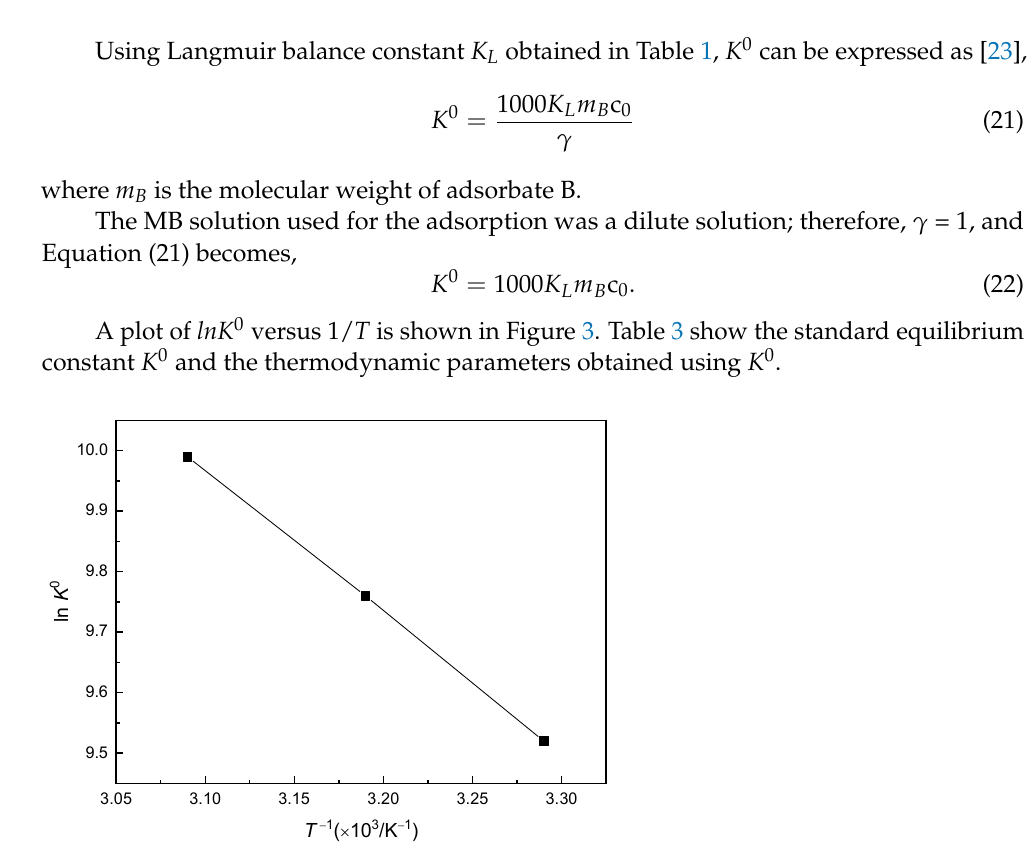
Figure 3. The relationship between lnK 0 and 1/T. Table 3. Thermodynamic parameters calculated using K 0 .